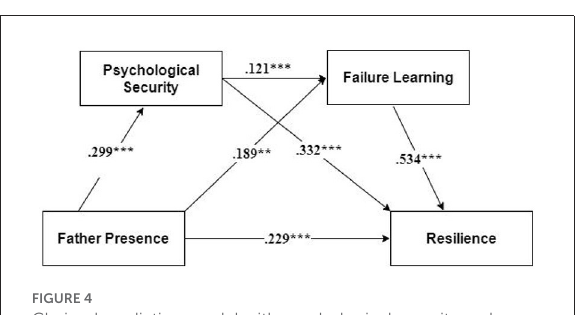
FIGURE4 Chained mediation model with psychological security